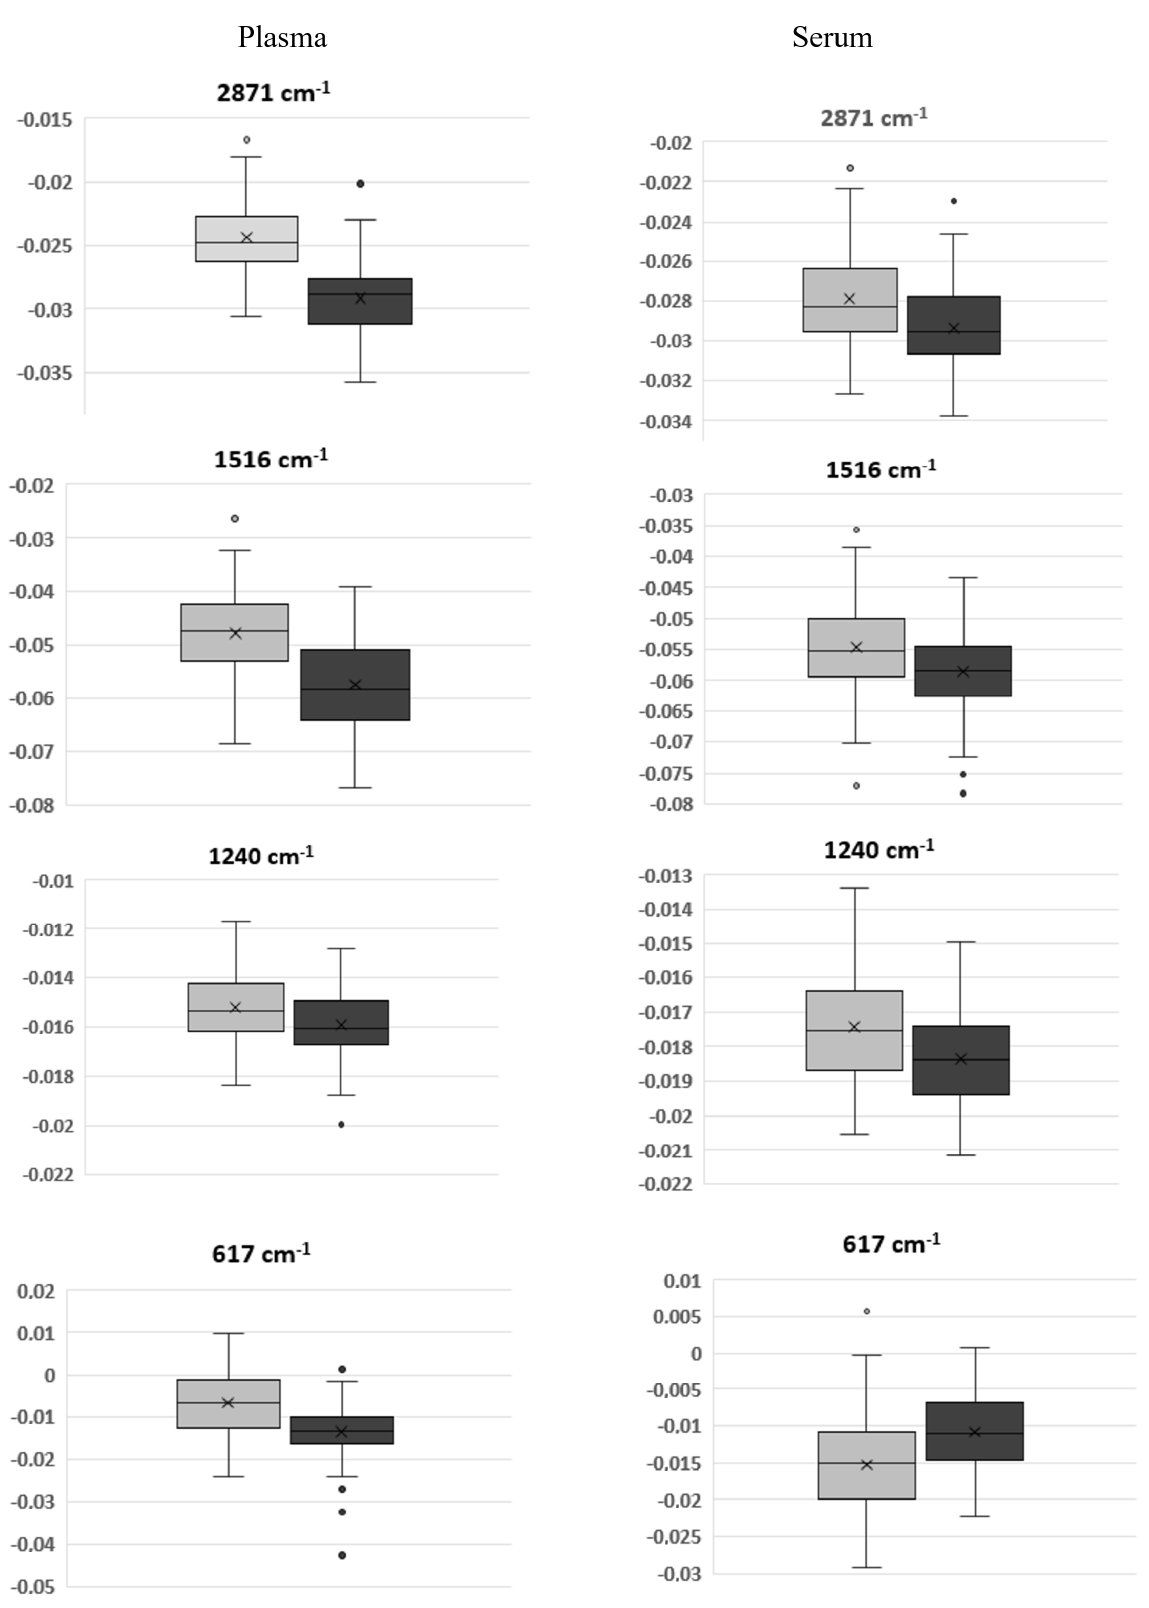
Figure 5. Boxplots of some negative bands of the normalized second derivative spectra of plasma (left side graphs) and serum (right side graphs). Grey and black panels display T0 and T90 samples,